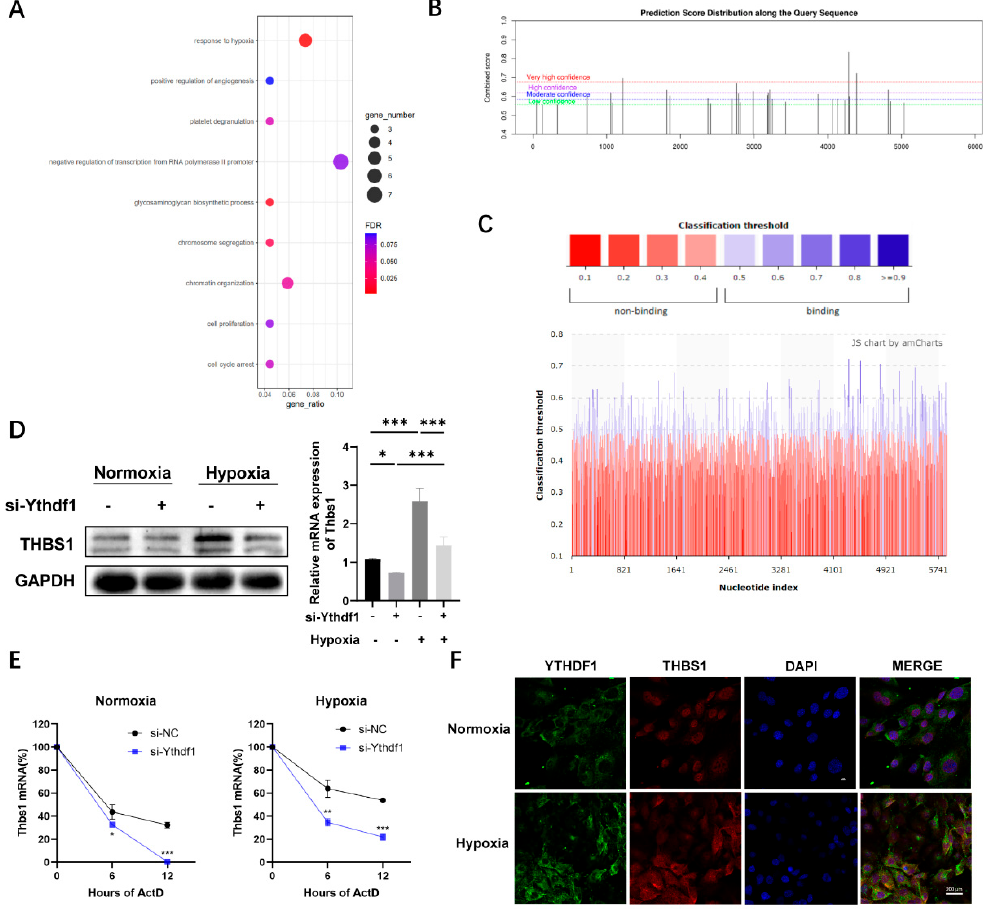
Figure 3. YTHDF1 mediates THBS1 mRNA stability via m 6 A modification. ( A ) Overlap of YTHDF1-binding peaks and m 6 A-containing peaks obtained from microarray data available at https://share.weiyun.com/xcB3waFn, go biological process enrichment analysis of the peaks overlap were performed using DAVID bioinformatics database. ( B ) SRAMP program predicted m 6 A sites in THBS1 mRNA. H: highly putative predicted m 6 A sites; V–H: very highly putative predicted m 6 A sites. ( C ) Prediction of binding sites between YTHDF1 protein and THBS1 mRNA by PRIdictor. ( D ) expression of THBS1 transfected with silenced YTHDF1 under normoxia and hypoxia was detected using Western blot and qRT-PCR. ( E ) RNA stability assays showed THBS1 mRNA of chondrocytes transfected with silenced YTHDF1. ( F ) The expression and location of YTHDF1 and THBS1 were measured by Immunofluorescence (IF) assays in MC3T3-E1 cells cultured for 24 h under normoxia (21% O 2 ) or hypoxia (1% O 2 ). Scale bar, 200 μ m, n = 3. Results are presented as mean ± SD. The p values were calculated by one-way ANOVA followed by Tukey’s test (* p < 0.05, *** p < 0.001, compared with the control group). YTHDF1, Yth m 6 A RNA-binding protein 1; THBS1, thrombospondin-1; Act D, actinomycin D.